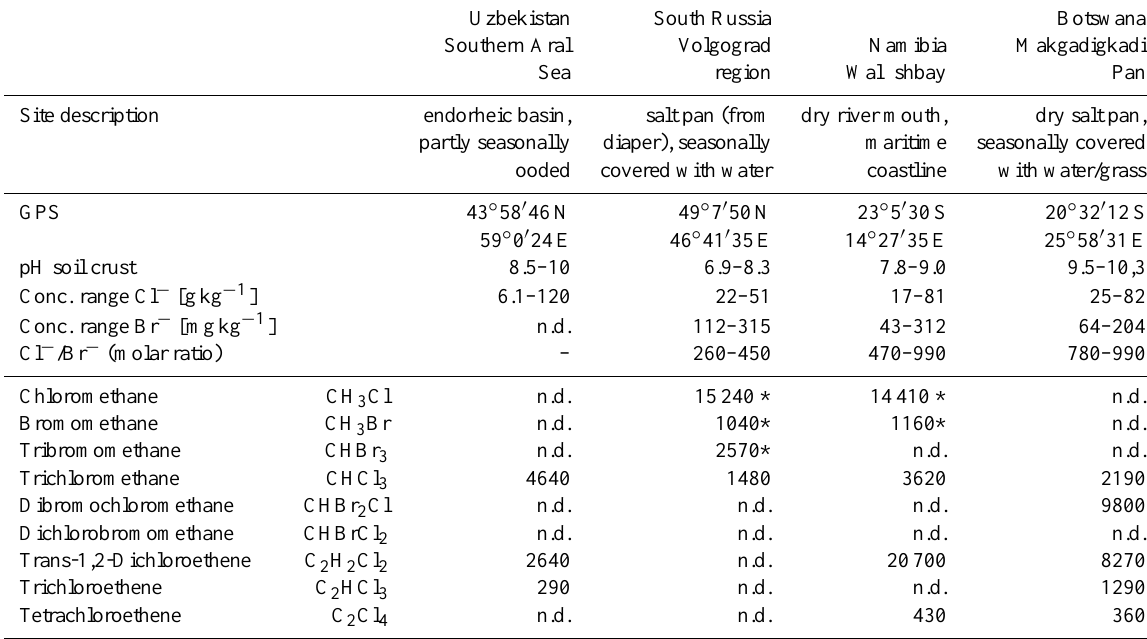
Table 3. Typical VOX emission characteristic of saline soils and sediments of different origin using purge-and-trap GC/MS analysis; 24h incubation time under condition of moisten or dry saline sediment [ngm − 2